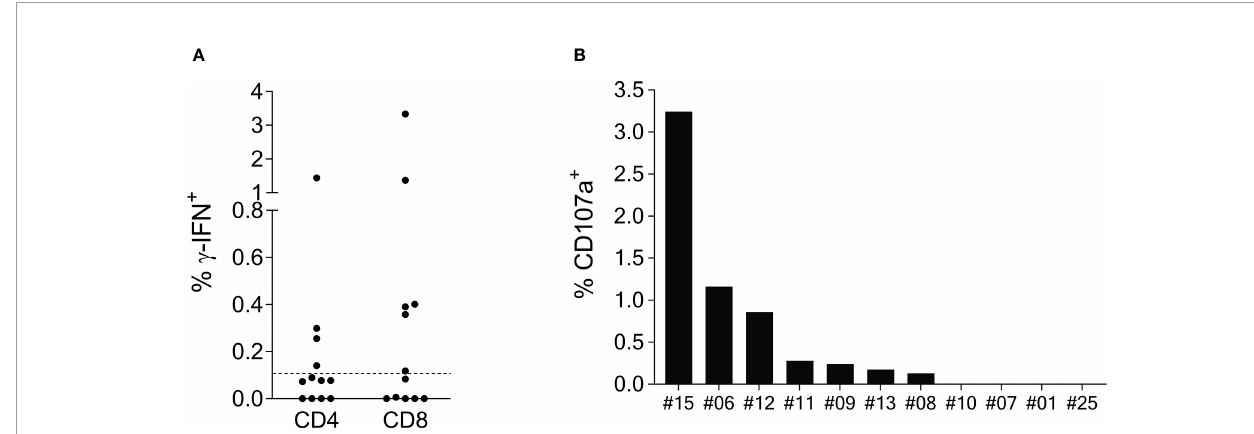
FIGURE 2 | SCoV-DP15-speci fi c T-cell lines express g -IFN and CD107a mainly in the CD8 + population. (A) : g -IFN expression: T-cell lines were incubated overnight with SCoV-DP15 peptide at a fi nal concentration of 20µg/ml, followed by intracellular staining of g -IFN (Details see methods section). T-cell lines that were incubated overnight without addition of peptides served as negative controls to assess for background g -IFN secretion and CD107a expression. Shown are g -IFN expressing CD4 + or CD8 + memory T-cells (CD45RO + ). Results were considered positive when the percentage of g -IFN positive cells after subtraction of background was >0.1% as indicated with a dashed line. (B) CD107a expression on CD8 + memory T-cells: CD107a expression was analyzed in T-cell lines in parallel to the analysis of g -IFN secretion. CD107a responses after subtraction of background of >0.1% were considered